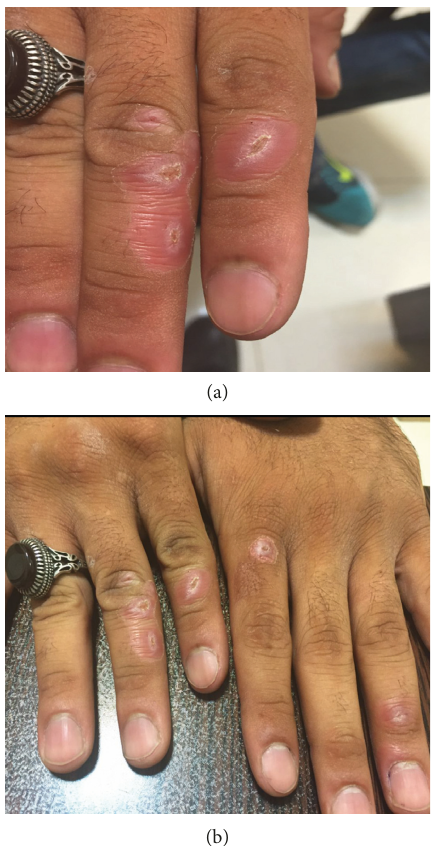
Figure 2: Ulcers healed 3 weeks after the start of the